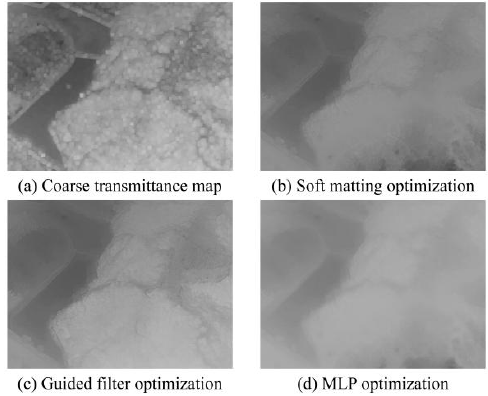
Figure 3. Coarse transmission optimization comparison: (a) Coarse transmittance map. (b) Soft matting optimization. (c) Guided filter optimization. (d) MLP